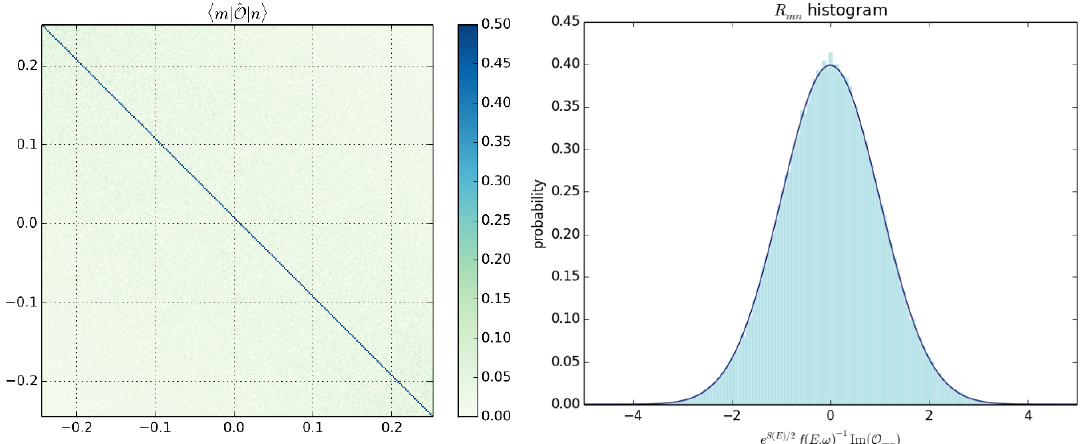
Figure 1 . Absolute values of matrix elements jO nm j = jh n jOj m ij for the single-site number operator O = ^ n N at half (cid:12)lling (cid:23) = 1 . Left panel : we show the absolute values of matrix elements against 2 their energies E n =J labelled along horizontal and vertical axes for a single realization at N =